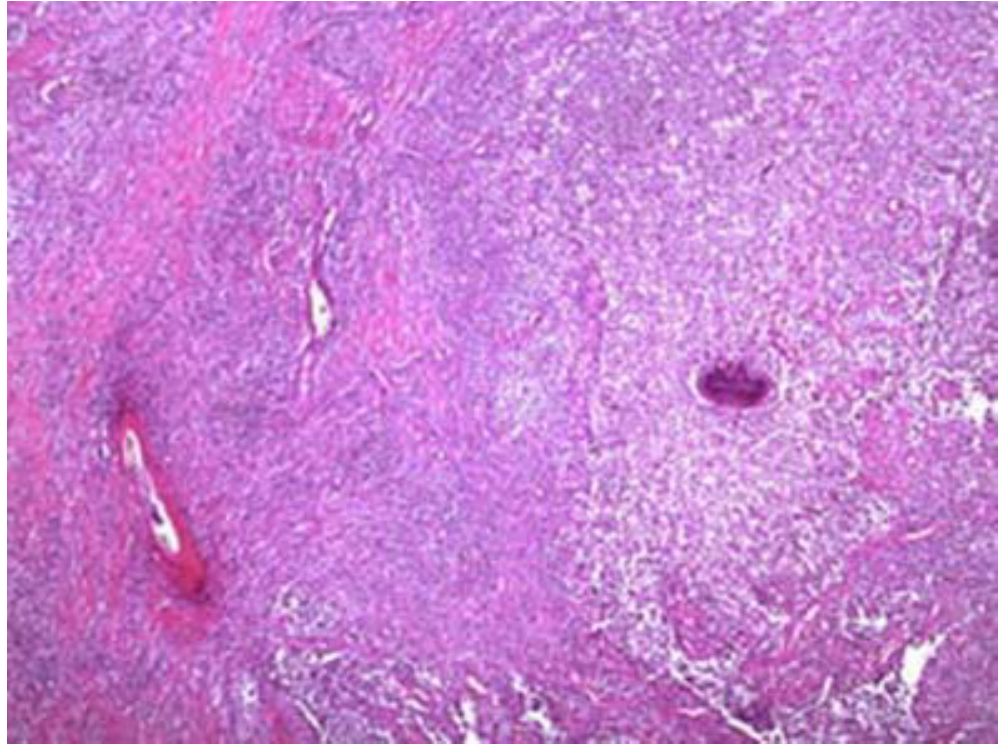
FIGURE 2. Sulfur granule consistent with actinomycosis and hair shaft with acute inflammation, 40 ×